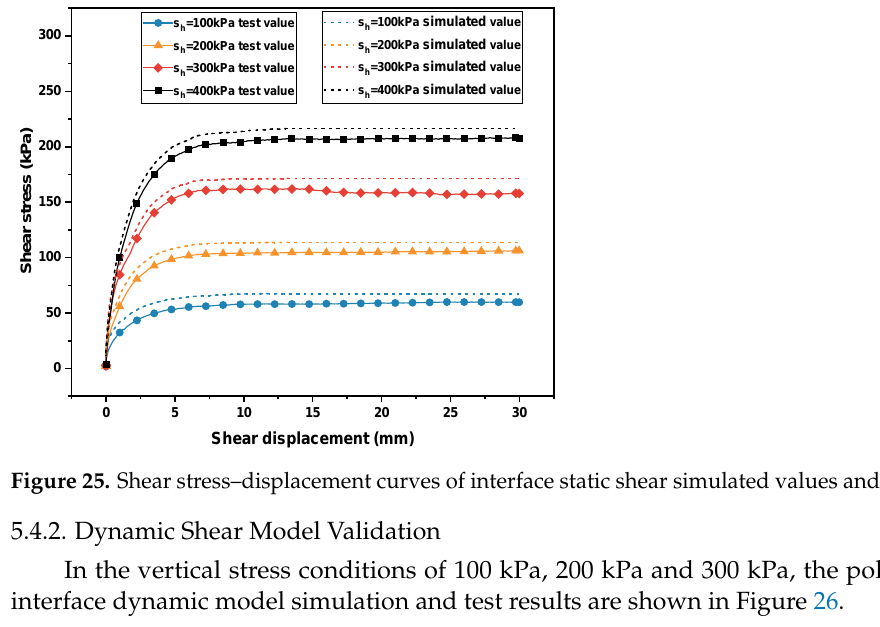
Figure 25. Shear stress – displacement curves of interface static shear simulated values and test val- ues.